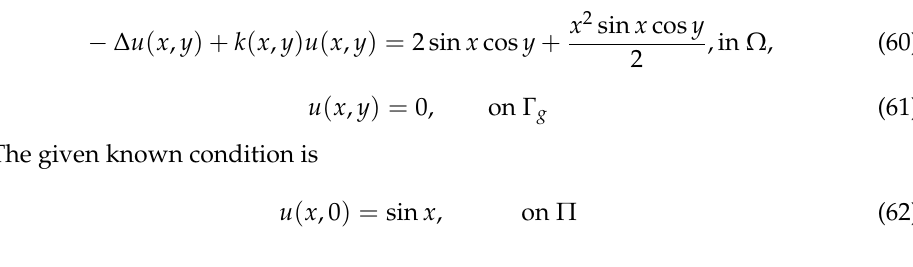
Figure 13. Convergence of wave number for the 2D constant parameter identification problem in irregular geometry.